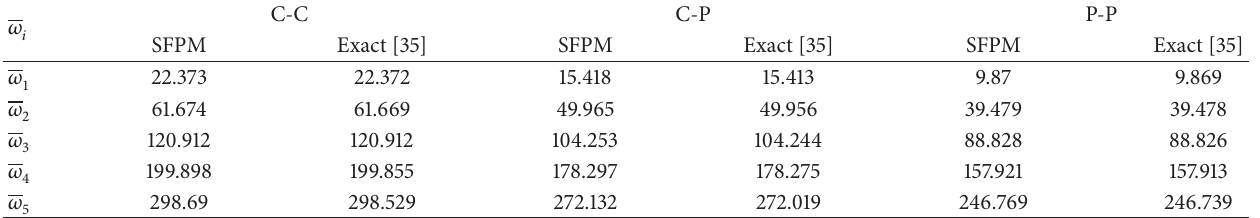
Table 2: First five nondimensional transverse natural frequencies 𝜔 𝑖 for uniform beams with various boundary conditions. C-C C-P P-P 𝜔 𝑖 SFPM Exact [35] SFPM Exact [35] SFPM Exact